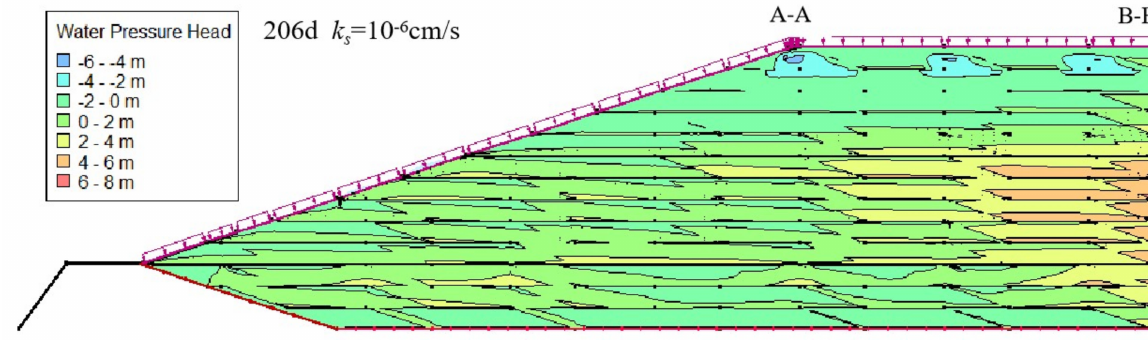
Figure 9. Leachate migration with daily covering soil with hydraulic conductivity of 10 − 6